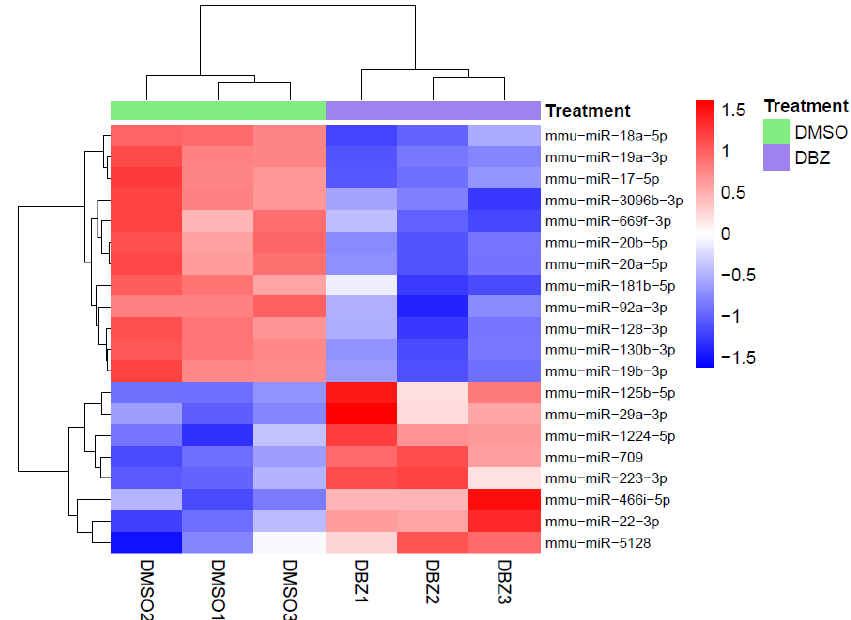
Figure 1. Heat map of significantly regulated miRNAs following NOTCH1 inhibition in vivo. MiRNA expression profiling was performed in three biological replicates of an HD-ΔPEST- NOTCH1 T-cell tumor treated in vivo with vehicle (DMSO) or with 5 mg/kg of dibenzazepine (DBZ). The heat treated in vivo with vehicle (DMSO) or with 5 mg / kg of dibenzazepine (DBZ). The heat map map shows the significantly differentially expressed miRNAs (|FC| > 1.3; FDR < 0.05). A hierarchical clustering was performed using the Euclidean distance and the complete linkage method on both samples (columns) and miRNAs (rows). The unsupervised analysis clearly separated two clusters representing downregulated miRNAs (top) and upregulated miRNAs (down) in DBZ-treated vs. control.